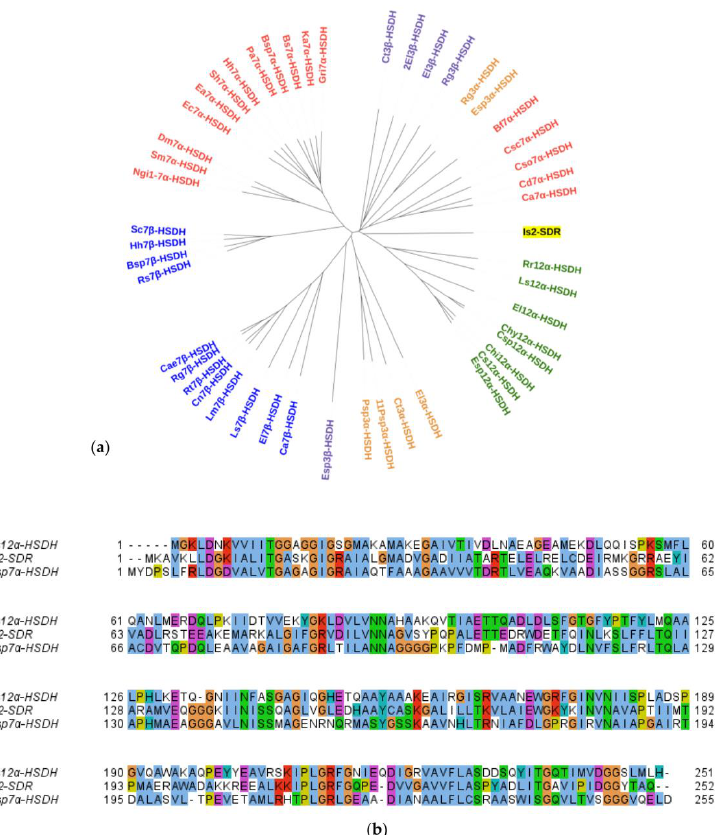
Figure 1. Sequence analysis of Is2-SDR. ( a ) Phylogenetic analysis of Is2-SDR with a set of HSDHs with different regio- and stereoselectivity (for details about the HSDH sequences see ref. [19]); ( b ) multiple sequence alignment of Is2- SDR with the 12α -HSDH from Lysinibacillus sphaericus (Ls12α - HSDH ) and the 7α -HSDH from Bosea sp. (Bsp7α -HSDH). Subsequently, the preliminary characterization of Is2-SDR after recombinant produc- tion in Escherichia coli demonstrated that, although showing NADPH-dependent reduc- tase activity toward different ketones, this new enzyme could not be classified as a HSDH since it did not accept any of the tested bile acids as substrates [20]. Nonetheless, very interesting results were obtained when using Is2-SDR in the bio- catalyzed reduction of selected bulky substrates. Specifically, this novel biocatalyst per- mitted a kinetic resolution of the so-called Wieland – Miescher ketone, a useful intermedi- ate in the synthesis of various complex natural products [22], as well as the stereoselective reduction of the bulky – bulky ketone 6-gingerol [23] (see the results and discussion sec- tions for further details). In this work, we report about the functional characterization of Is2-SDR, which per- mitted us to further highlight the broad substrate scope and outstanding stability of this